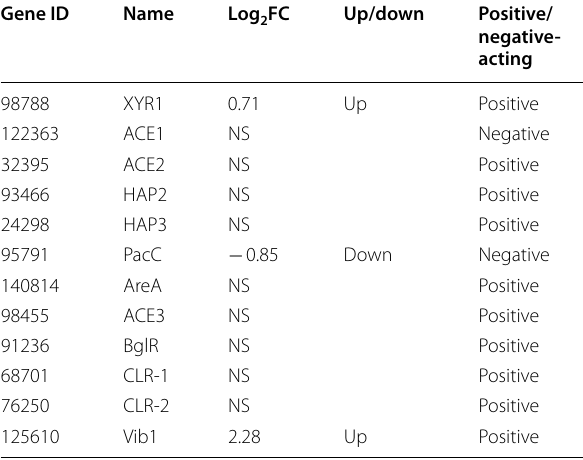
NS, nonsignificant at P adj > 0.05; Lac: lactose